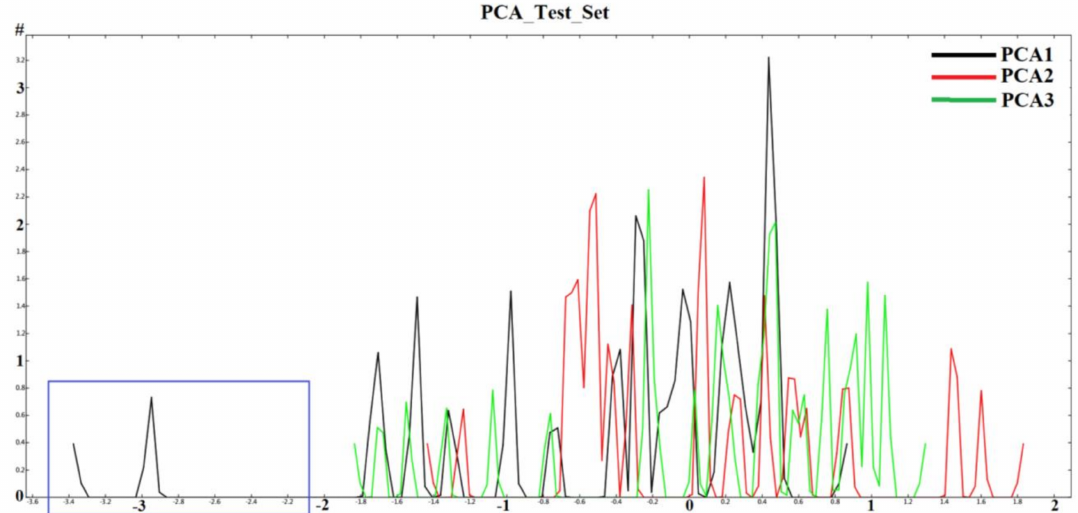
Figure 8. 2D plots to visualize the variation of the three most important computed principal components for the test set (Blue box represent the outlier; compound 24 ).